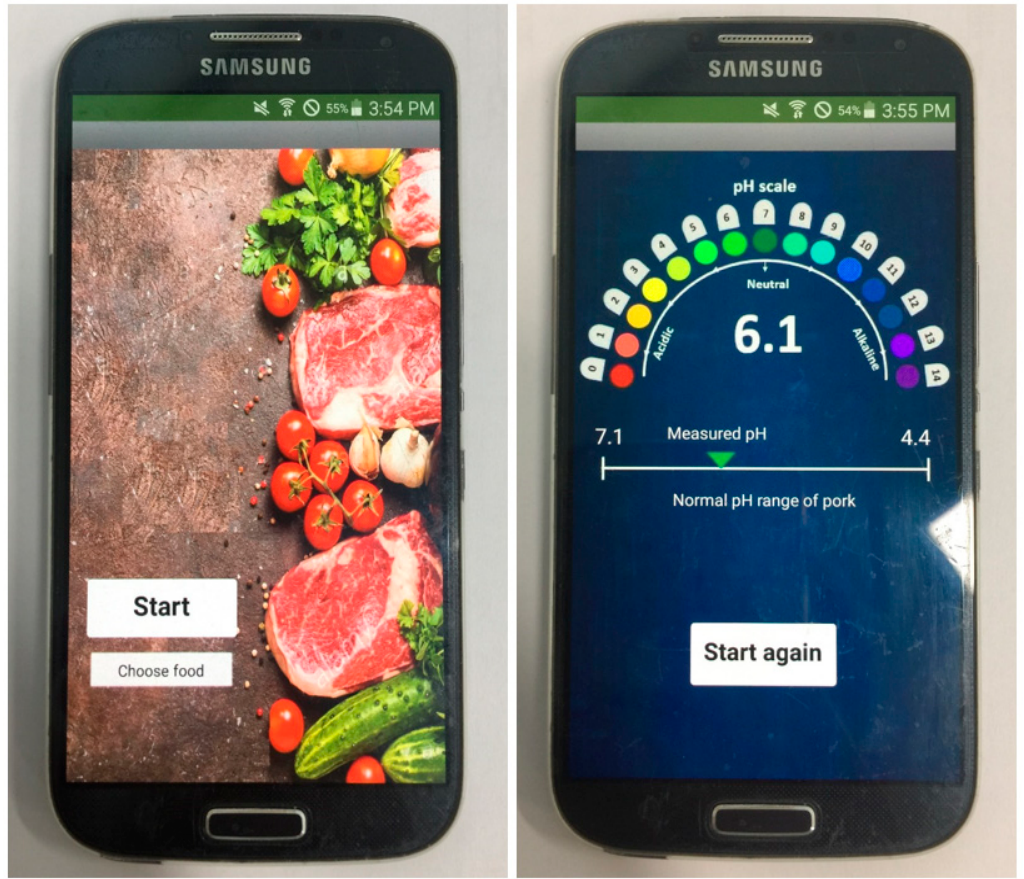
Figure 7. The user interface of the developed Android-based mobile application for food freshness